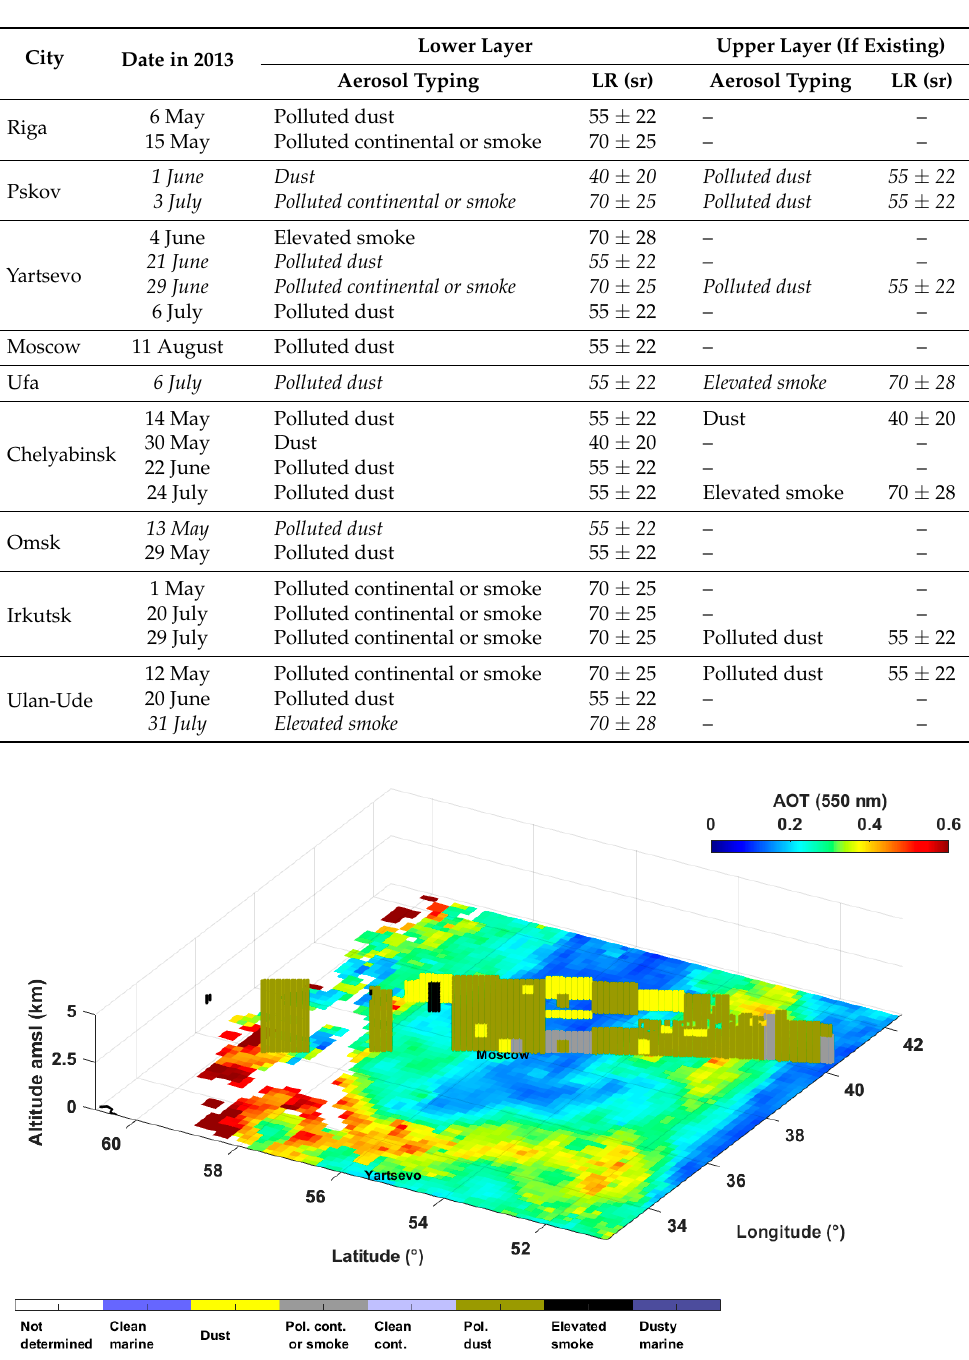
Table 4. CALIOP observations recorded above the Eastern European (Riga) and Russia cities included in this study between 1 May and 31 August 2013. The aerosol type attributed to the layer and the LR value associated with this type in CALIOP inversion process are indicated. Plain text is used when the orbit track passes exactly over the city while italic text is used when it passes only nearby (distance <20 km). When CALIOP algorithm detected two superimposed aerosol layers with different optical properties, both are indicated.